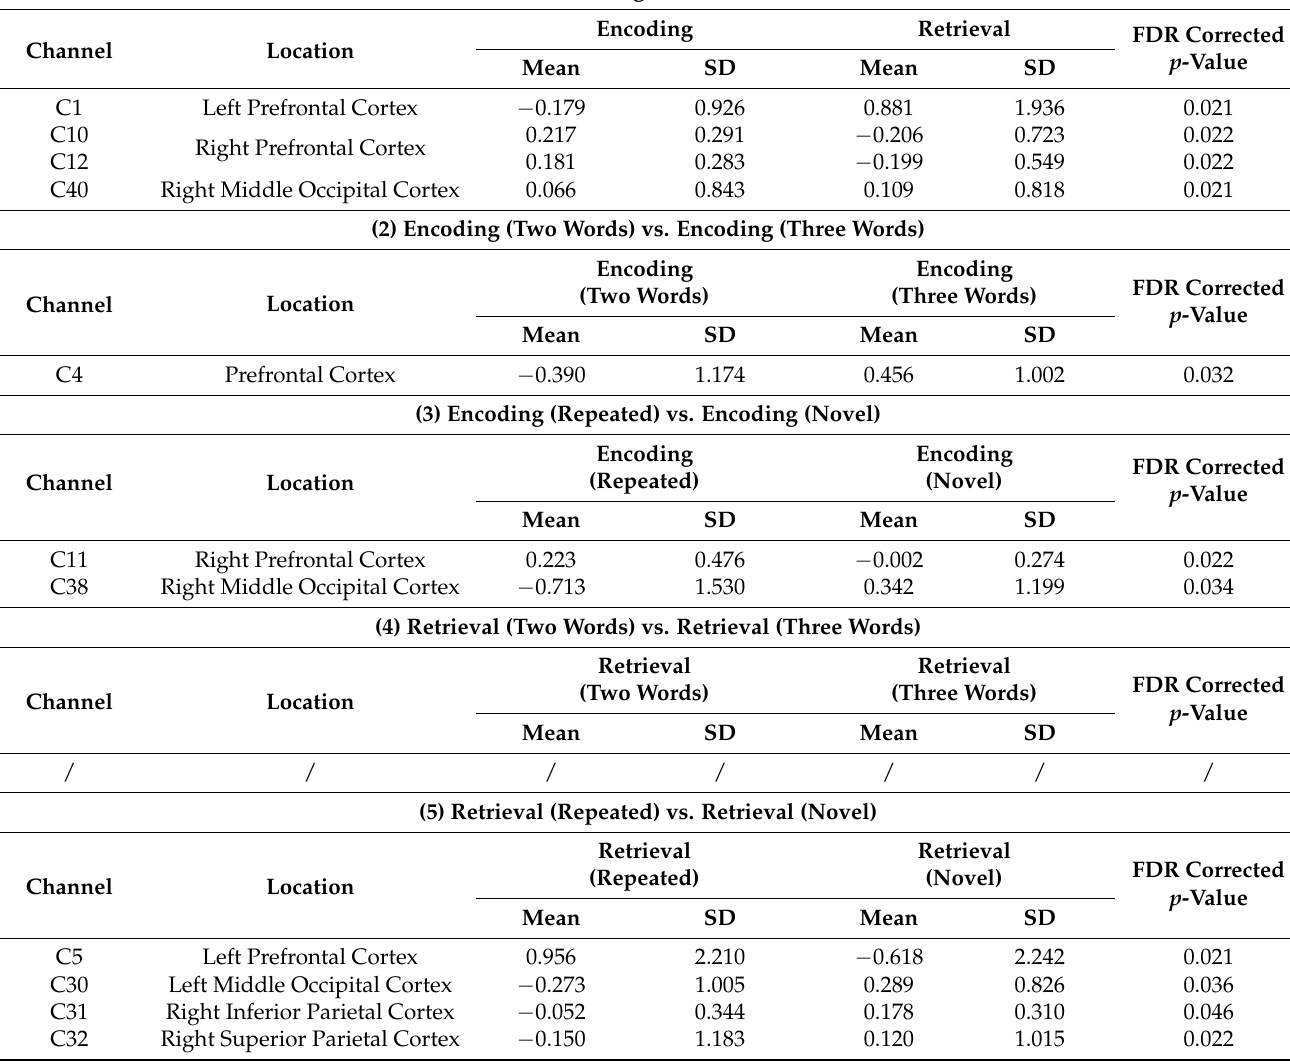
Table 2. The significance of beta values in different conditions. (1) Encoding vs.